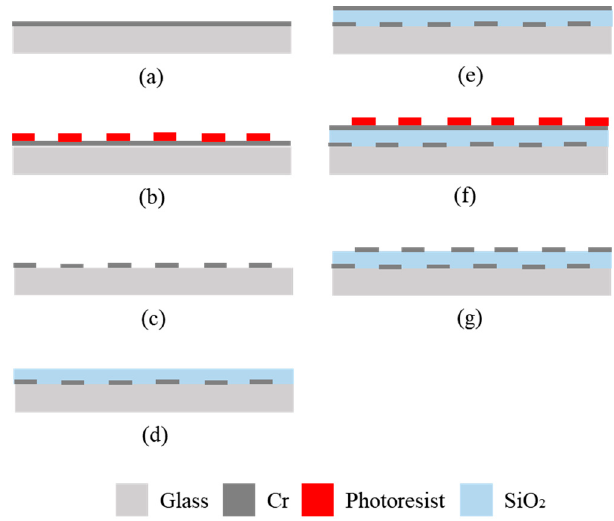
Figure 4. Fabrication process of the tactile display. ( a ) Cr layer deposition; ( b ) photoresist patterning; ( c ) Cr etching; ( d ) SiO 2 deposition; ( e ) Cr layer deposition; ( f ) photoresist patterning; ( g ) Cr etching.